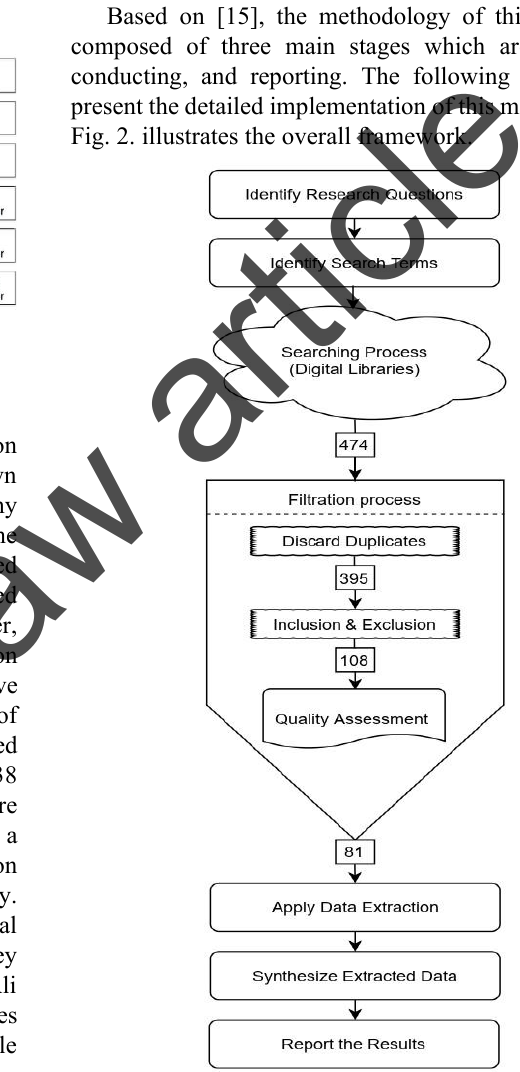
Figure 2 Research